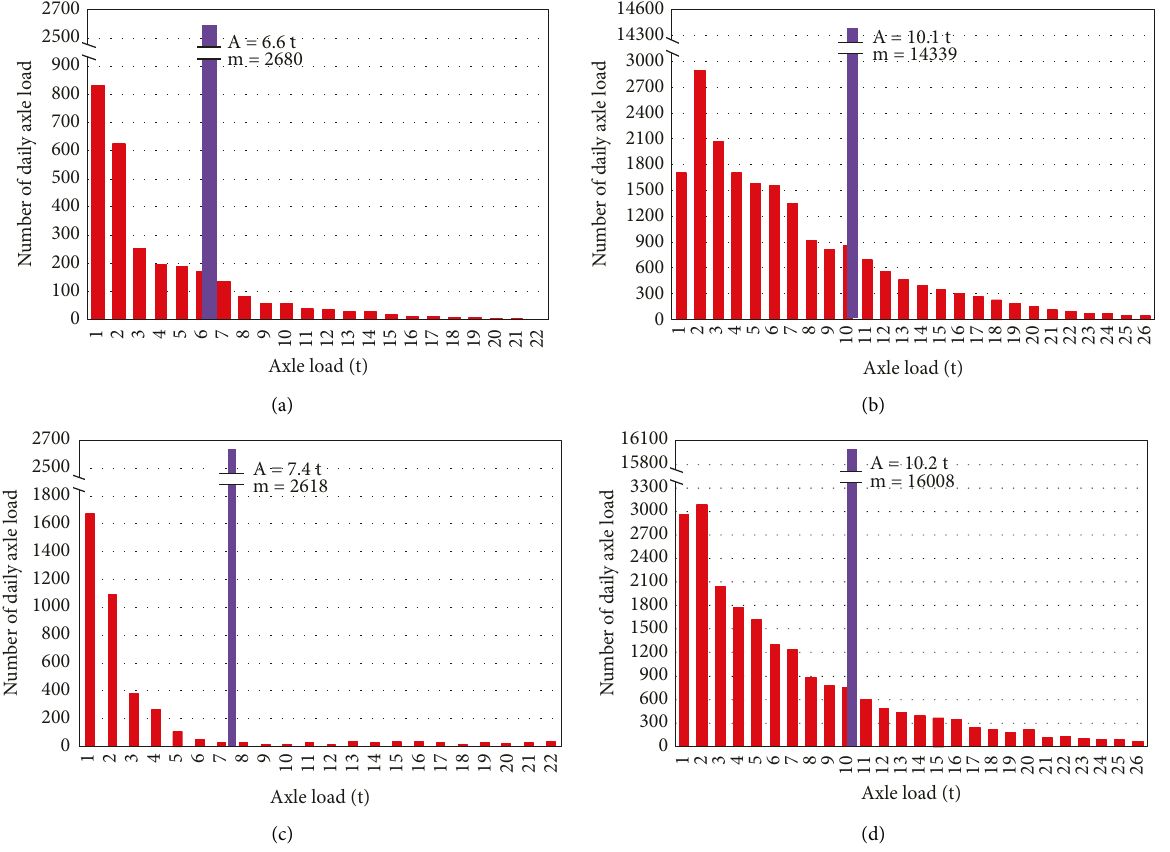
Figure 9: Axle load distribution and equivalent axle load. (a) Lane 1. (b) Lane 2. (c) Lane 3. (d) Lane 4. Table 5: Vehicular load spectra and fatigue loading contribution.